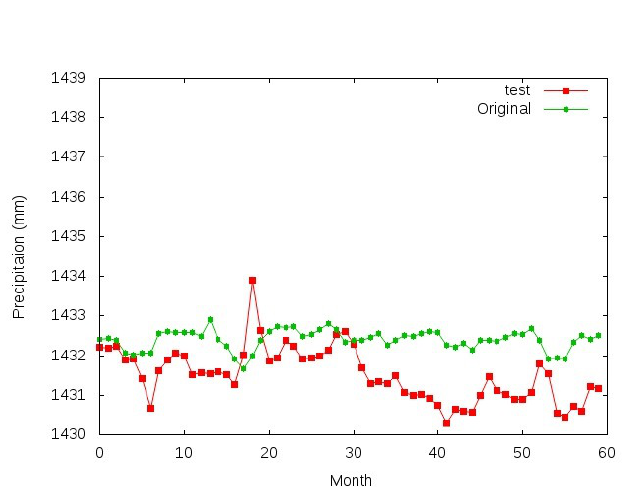
Fig. 6: Result under 200 hidden units and x 2 + x function